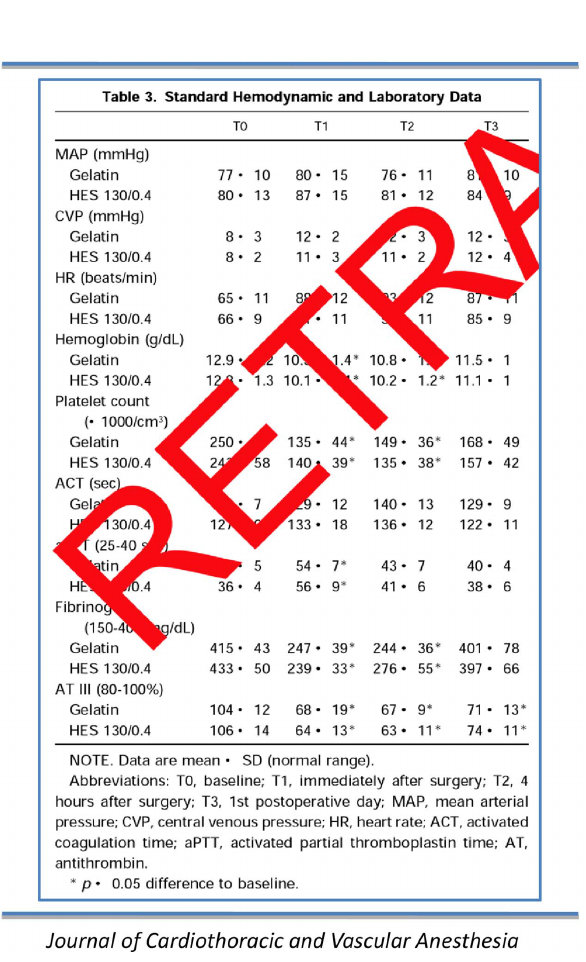
Figure 3. Opaque watermark. Journal of Cardiothoracic and Vascular Anesth